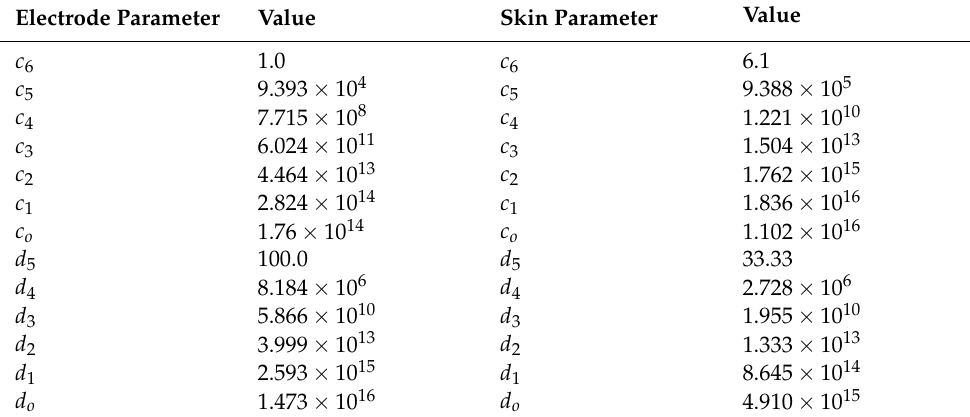
Table 4. Parameters for the implementation of expression H(s) (12).